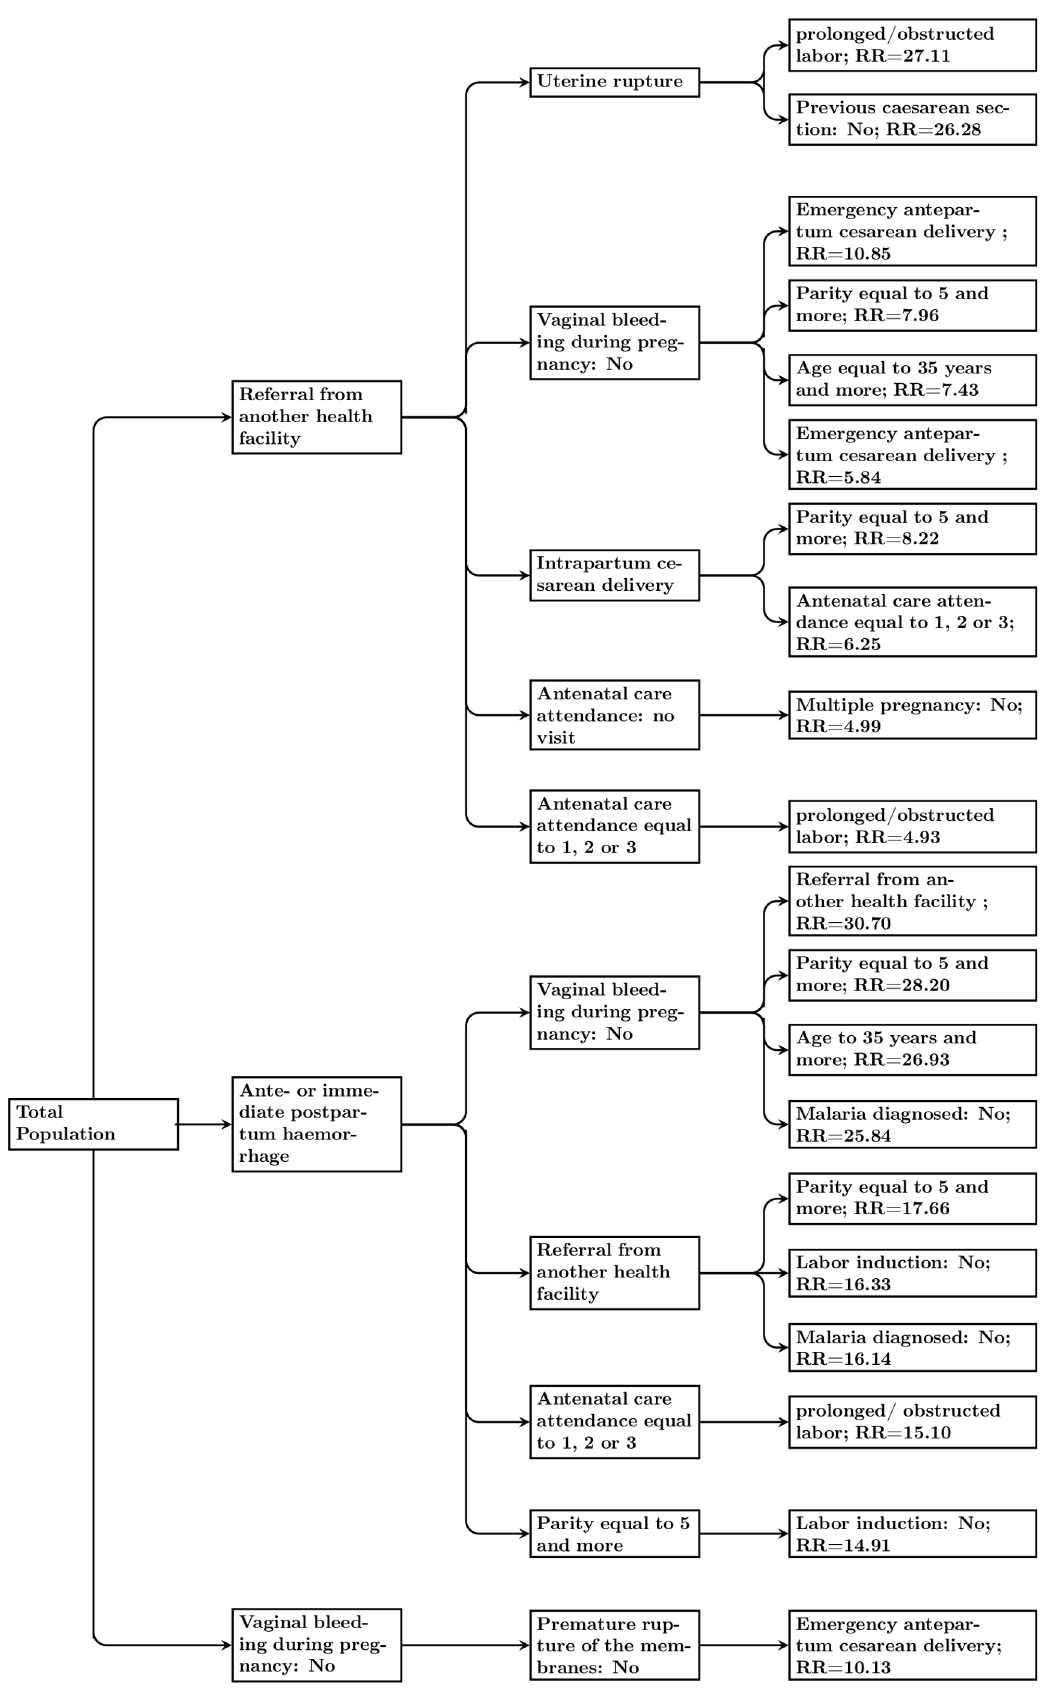
Figure 1. Tree representation of the twenty rules mined. doi:10.1371/journal.pone.0064157.g001 PLOS ONE |